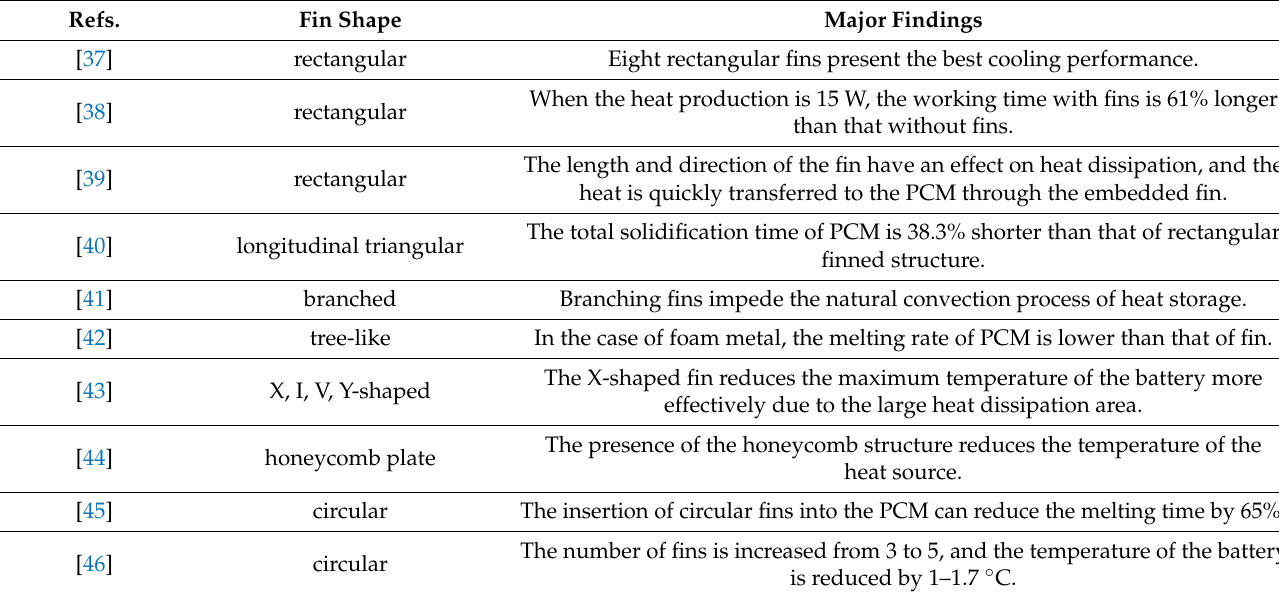
Table 1. A review of research on various fin shapes. Refs. Major